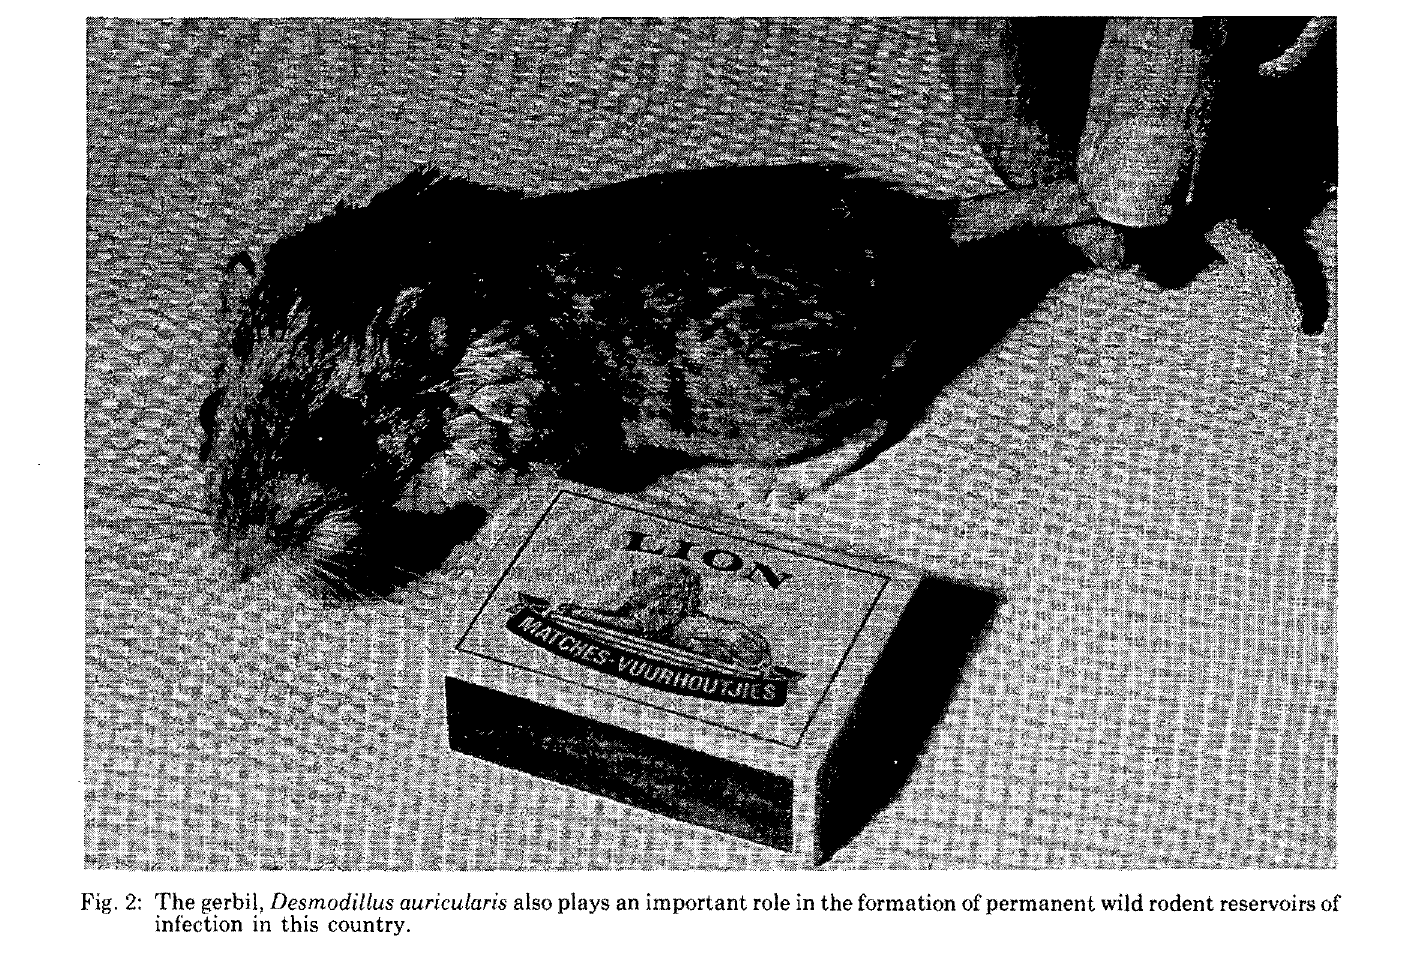
Fig. 2: :r~e g~rbi!, De~modillus auricularis also plays an important role in the formation of permanent wild rodent reservoirs of IllfectlOn III this